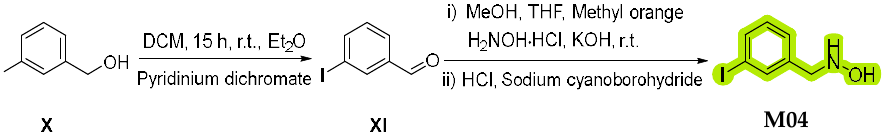
Figure 16. Synthetic route for the preparation of MO4 . THF (tetrahydrofuran), Potassium hydrox- ide, Starting material X is commercially available.